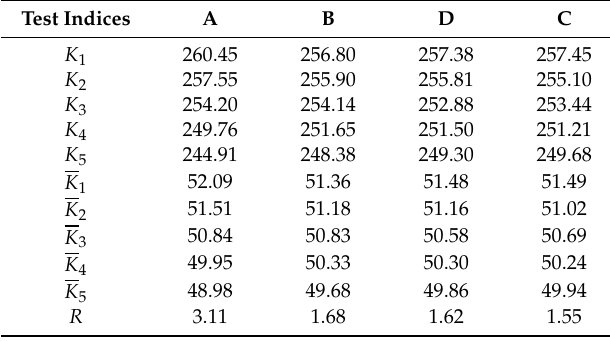
Table 5. Range analysis of η